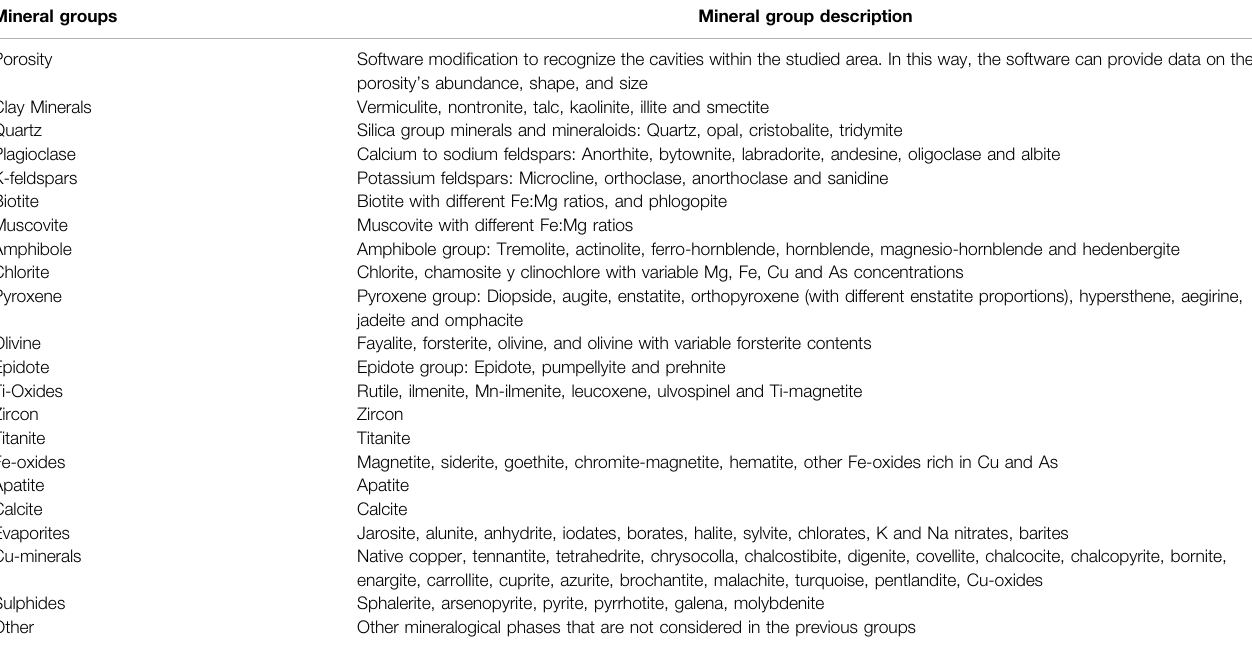
TABLE 2 | Summary of the mineralogical list used in the iDiscover software. The selected mineral groups correspond to rock-forming silicates and representative Cu-rich, sulphide and evaporite minerals found frequently in igneous, sedimentary, and metamorphic rocks in the Central Andes. Mineral